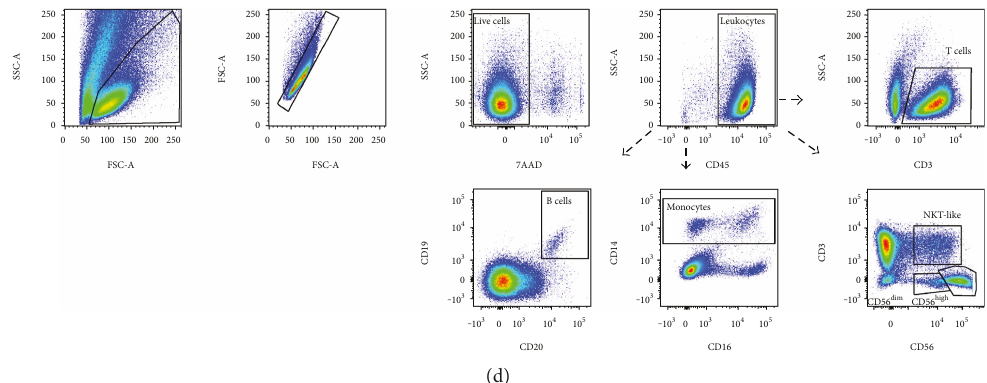
Figure 1: Di ff erent leukocyte populations in decidua parietalis and basalis. (a) OPLS-DA observation plot displaying a separation between leukocytes from decidua basalis and parietalis. (b) OPLS plot following a variable in fl uence on projection (VIP) of 0.98, showing associations between decidual compartment and phenotypic leukocyte markers ( n = 8 – 13 for (a, b)). (c) Distribution of major leukocyte subsets in paired samples of decidua basalis and parietalis compared with the nonparametric Wilcoxon test. Line in graphs depicts the median among values ( n =11-12). (d) Representative fl ow cytometry plots showing the initial gating strategy used throughout the paper, as well as the gating of the subsets in (c). ∗ p < 0 05 ; ∗∗ p < 0 01 ; ∗∗∗ p < 0 001